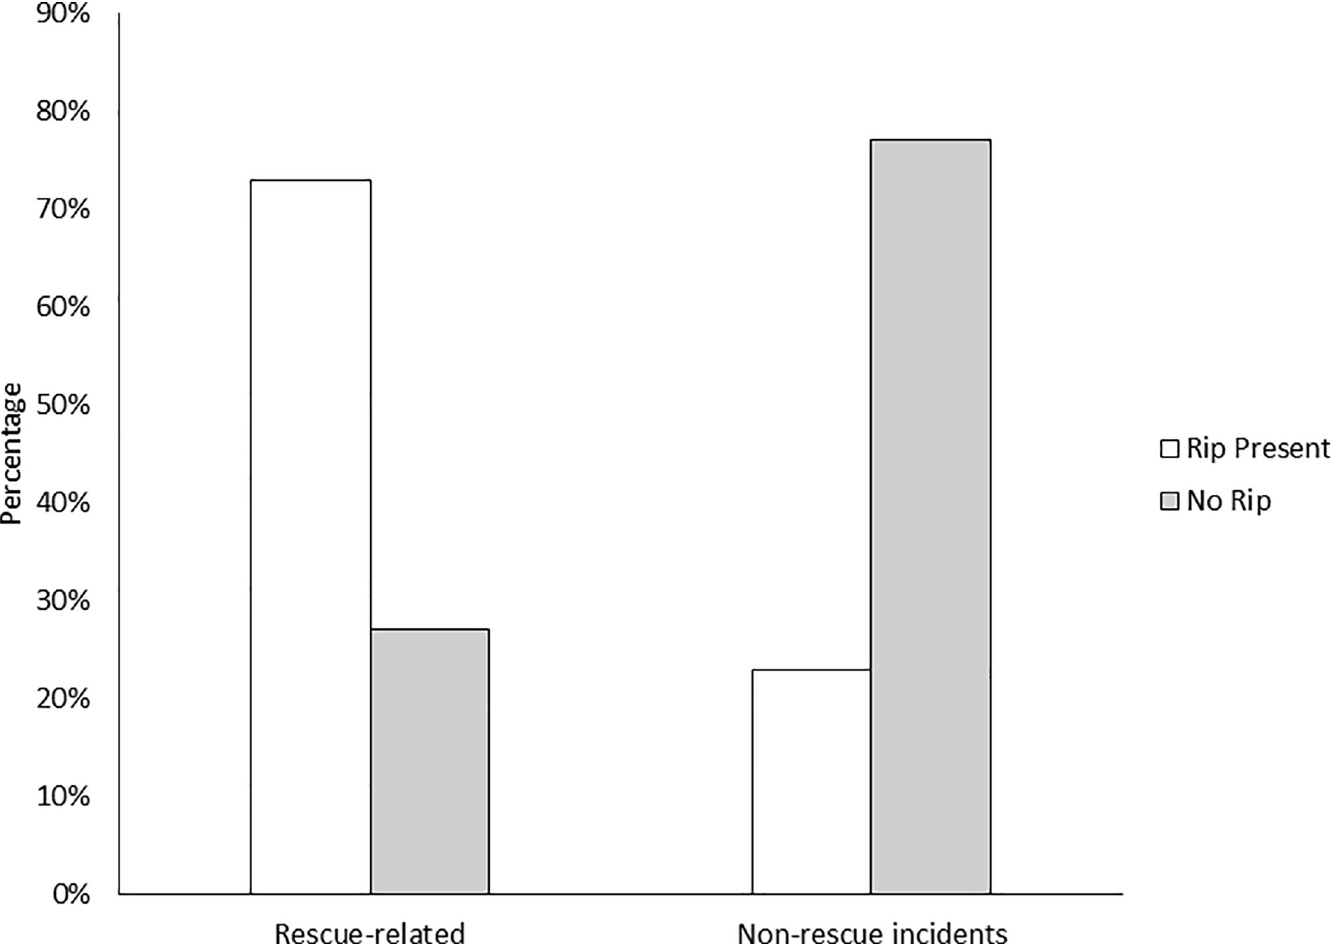
Fig 5. Presence of rip currents in fatal bystander rescues compared with non-rescue